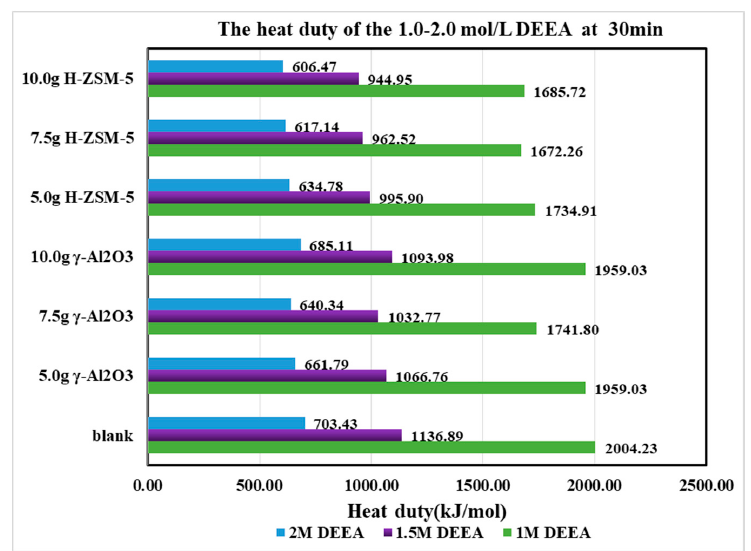
Molecules 2019 , 24 , x FOR PEER REVIEW 18 of 22 that period, most of the CO 2 desorption process was completed as the CO 2 loading decreased from 0.80 to 0.30 mol/mol. The CO 2 desorption curves did not shift significantly after loading <0.30 Figure 10. The heat duty of the DEEA at first 30 min from 1.0 to 2.0 mol/L at 363 K and 1 atm. mol/mol, since most [HCO 3 − ] was exhausted.